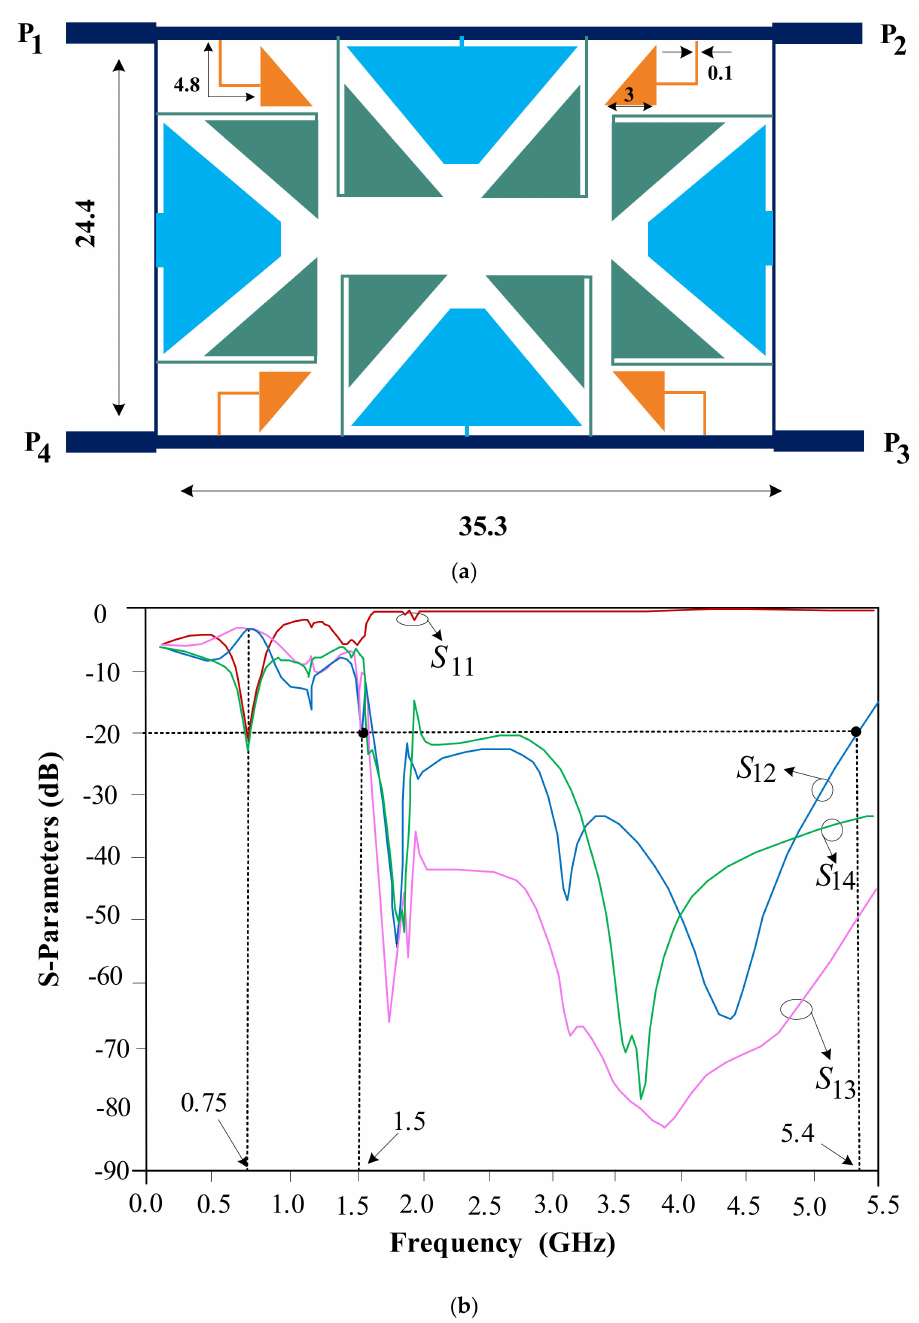
Figure 14. The final prototype of the designed coupler; ( a ) layout with dimensions in millimeters, and ( b ) EM simulation